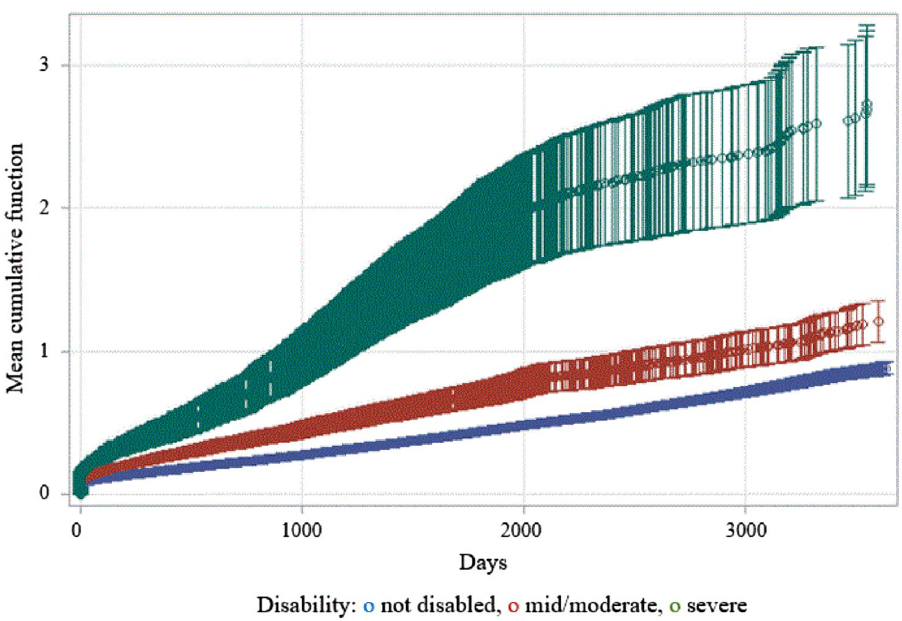
Figure 1. Cumulative mean function estimates for diabetes-related avoidable hospitalization according to disability